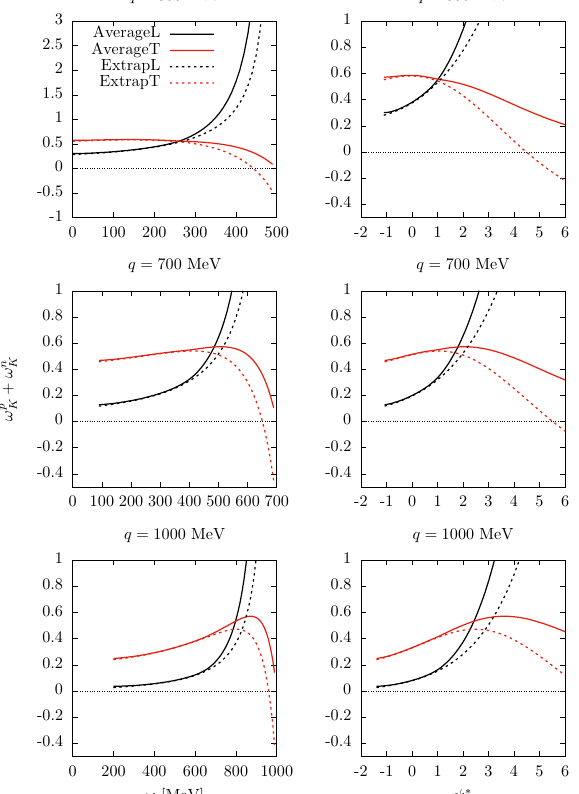
Figure 3. Averaged and extrapolated longitudinal and transverse response functions for protons plus neutrons, as a function of ω and of the scaling variable ψ ∗ , for three values of the momentum transfer.